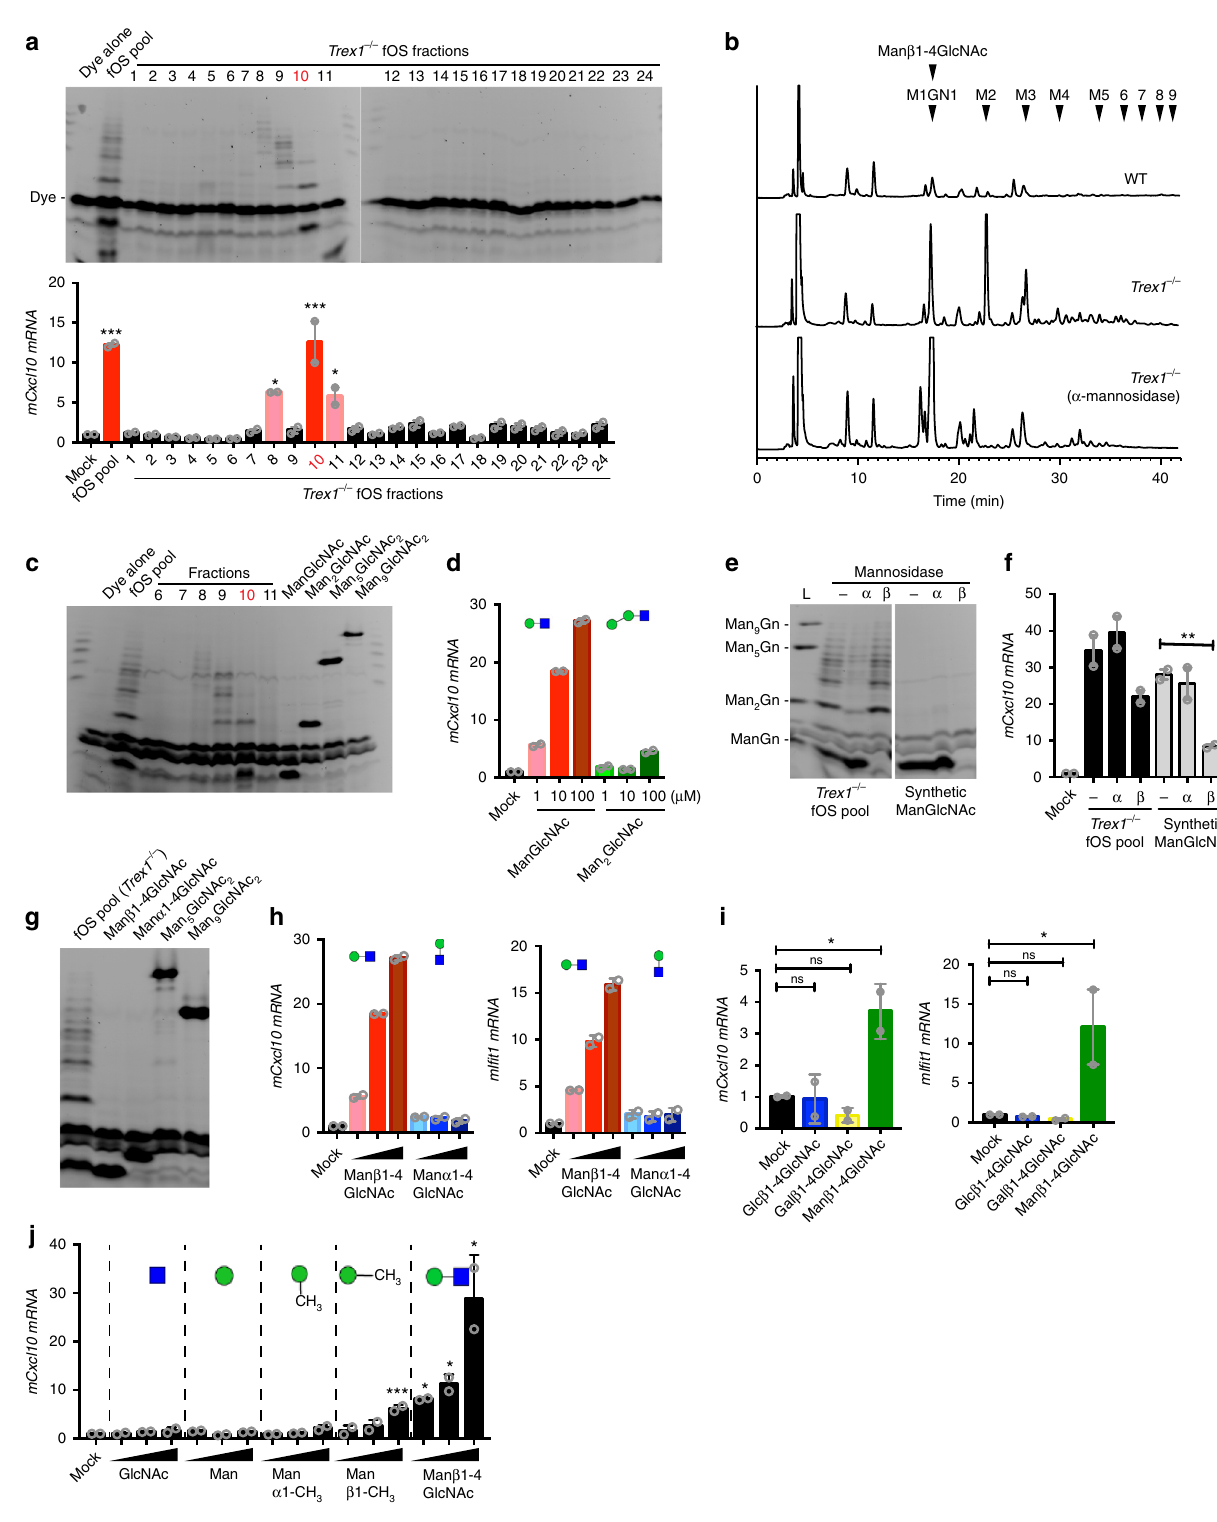
bioactivity of the synthetic ManGlcNAc disaccharide, whereas α - mannosidase treatment had no effect (Fig. 1f). The residual activity in β -mannosidase-treated fOS pool indicates that other immunogenic fOS species also present in the fOS pool, consistent with our earlier observation that bioactivies were detected in multiple fractions from the fOS